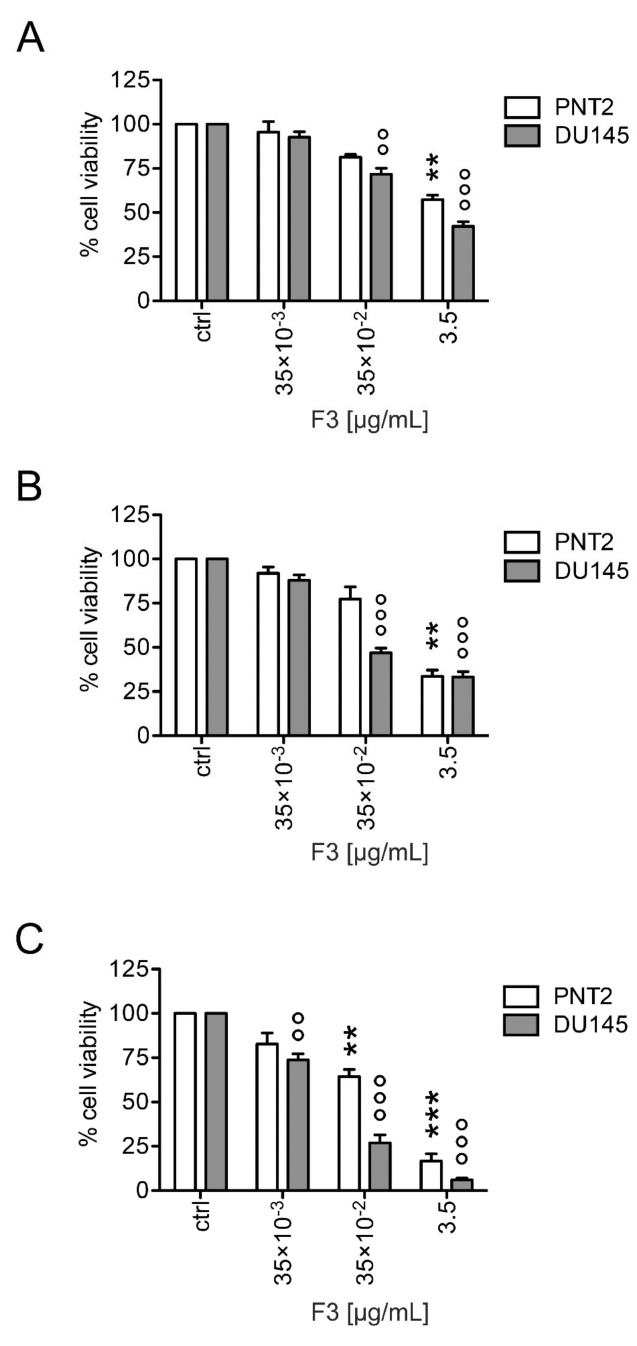
Figure 3. Inhibitory e ff ect of F3 on PNT2 and DU 145 cell viability. The cells were treated with di ff erent concentrations (35 × 10 − 3 , 35 × 10 − 2 and 3.5 µ g / mL) of F3 for 24- ( A ), 48- ( B ), and 72 ( C ) h. Data are expressed as mean ± SD of three independent experiments ** ( p < 0.01); *** ( p < 0.001) F3-treated PNT2 vs. untreated PNT2 (control); ◦◦ ( p < 0.01); ◦◦◦ ( p < 0.001) F3-treated DU 145 vs. untreated DU 145